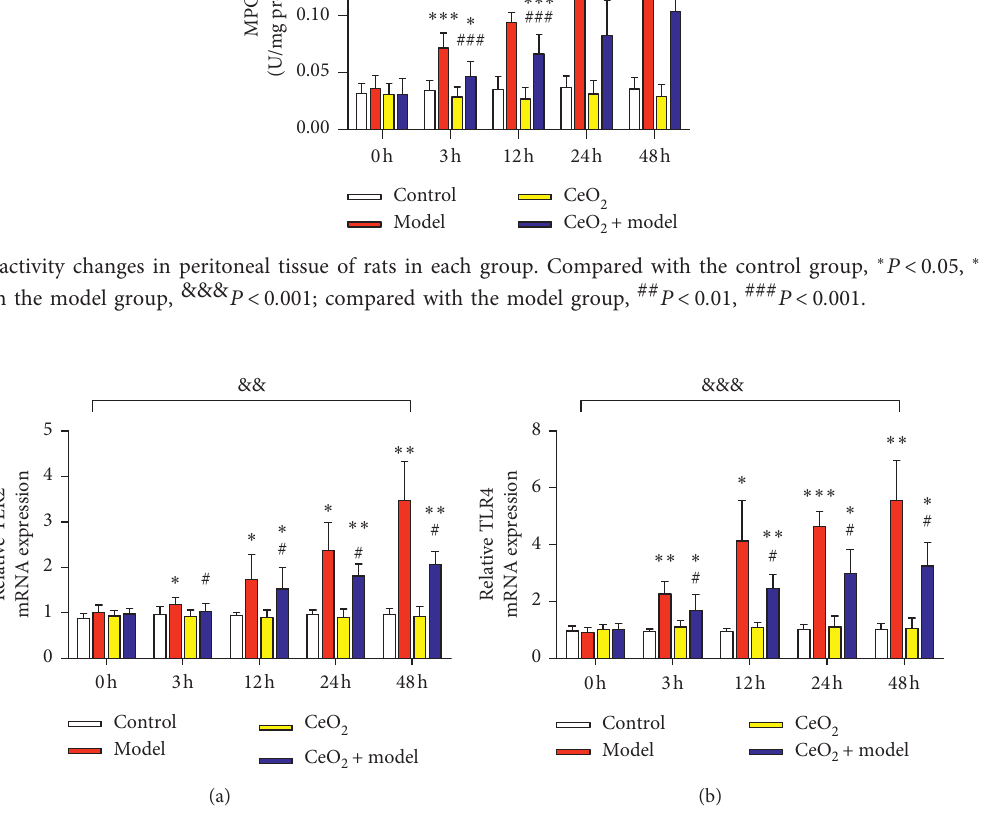
Figure 6: mRNA expression changes in the peritoneal tissue of each group of rats: (a) changes in mRNA expression levels of TLR2; (b) changes in mRNA expression levels of TLR4. Compared with the control group, ∗ P < 0 . 05, ∗∗ P < 0 . 01, ∗∗∗ P < 0 . 001; differences within the model group, && P < 0 . 01, &&& P < 0 . 01; compared with the model group, # P < 0 . 05.